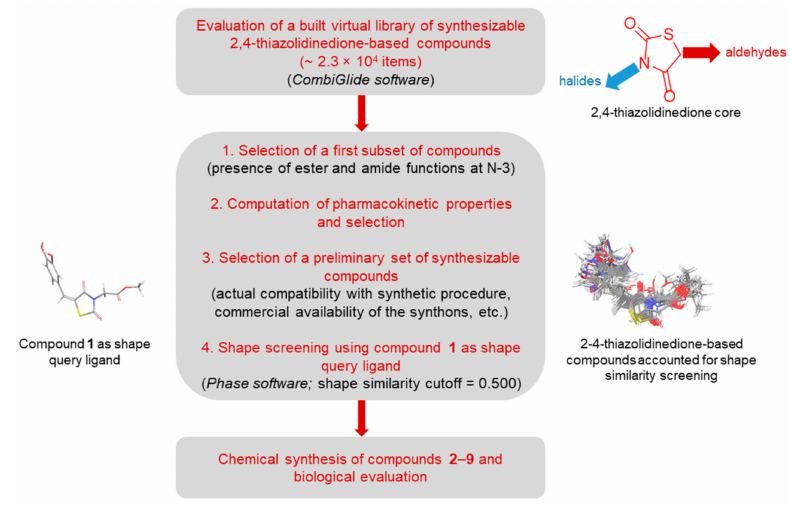
Figure 1. Virtual screening workflow leading to the selection of compounds 2 – 9 .